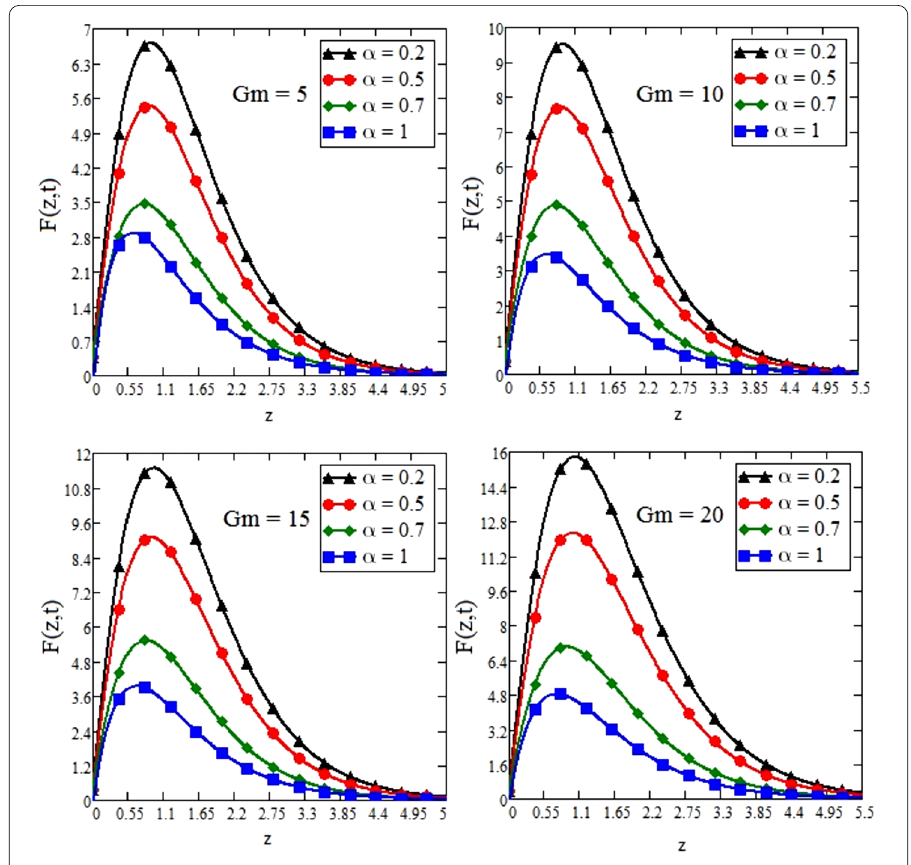
Figure 8 Impact of Gm on the velocity distribution of Jeffrey